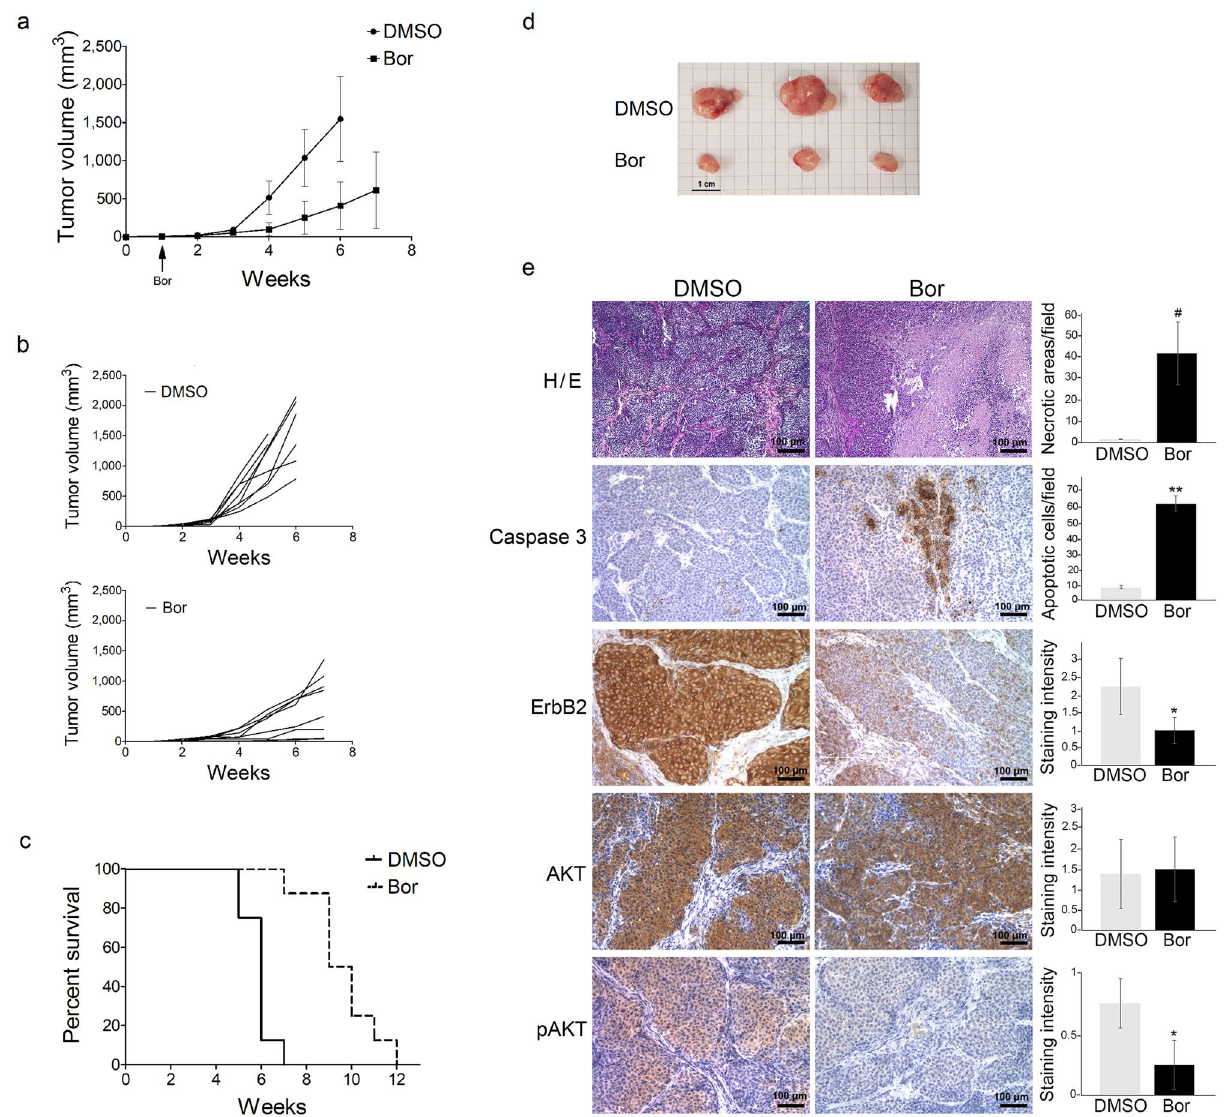
Figure 8. Bortezomib reduced tumor growth and increased the survival in BALB- neu T mice that were subcutaneously inoculated with SALTO-5 cells. ( a ) Differences in mean tumor volumes ± SD between BALB- neu T mice treated with Bortezomib (Bor) or PBS + DMSO. ( b ) Curves representing tumor growth in single mice treated with Bortezomib (Bor) or PBS + DMSO. ( c ) Differences in the mean survival duration of BALB- neu T mice treated with Bortezomib (Bor) or PBS + DMSO. ( d ) Representative photographs of explanted tumor masses after 5 weeks. Scale bar corresponds to 1 cm. ( e ) Histology and immunohistochemical analysis of tumors from Bortezomib-treated mice (Bor) or control-treated mice (PBS + DMSO). Tumors from three different mice for each group were stained using hematoxylin and eosin (H/E). Necrotic areas were quantified by ImageJ 1.53e software on 10 representative microscopic fields. Percentage average of necrotic areas are reported in the graph. IHC was performed to analyze the expression of cleaved caspase 3, ErbB2, AKT and phospho-AKT (pAKT) in tumor samples. Tumor tissues from three mice in each group were analyzed and representative images were reported. The number of cleaved caspase 3-positive cells (apoptotic cells) within the tumors was evaluated on 10 representative microscopic fields and the results are shown in the adjacent bar graph. Intensity of ErbB2, AKT and pAKT expression within the tumors was semiquantitative evaluated as described in Materials and Methods, and the results are shown in the adjacent bar graph (#: p = 0.0015; *: p = 0.04; **: p = 0.0001). Scale bars correspond to 100